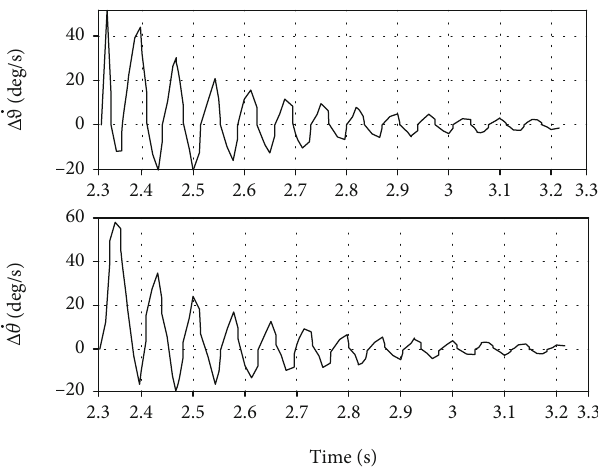
Figure 8: Curve of change rate of pitch angle.